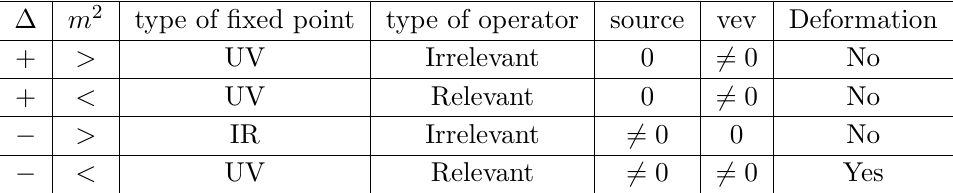
Table 1 . A classi(cid:12)cation of the deformation of the type (3.30) in terms of the signs of the squared masses and the choice of (cid:1) + or (cid:1) (cid:0) . The nature of the (cid:12)xed point when reached along (cid:30) r , i.e., r r where all the (cid:30) s with s 6 = r are set to zero, is indicated. When all the masses have the same sign and the dimensions are of the same kind, we can unambiguously classify the (cid:12)xed points, otherwise a single extremum may belong to di(cid:11)erent categories